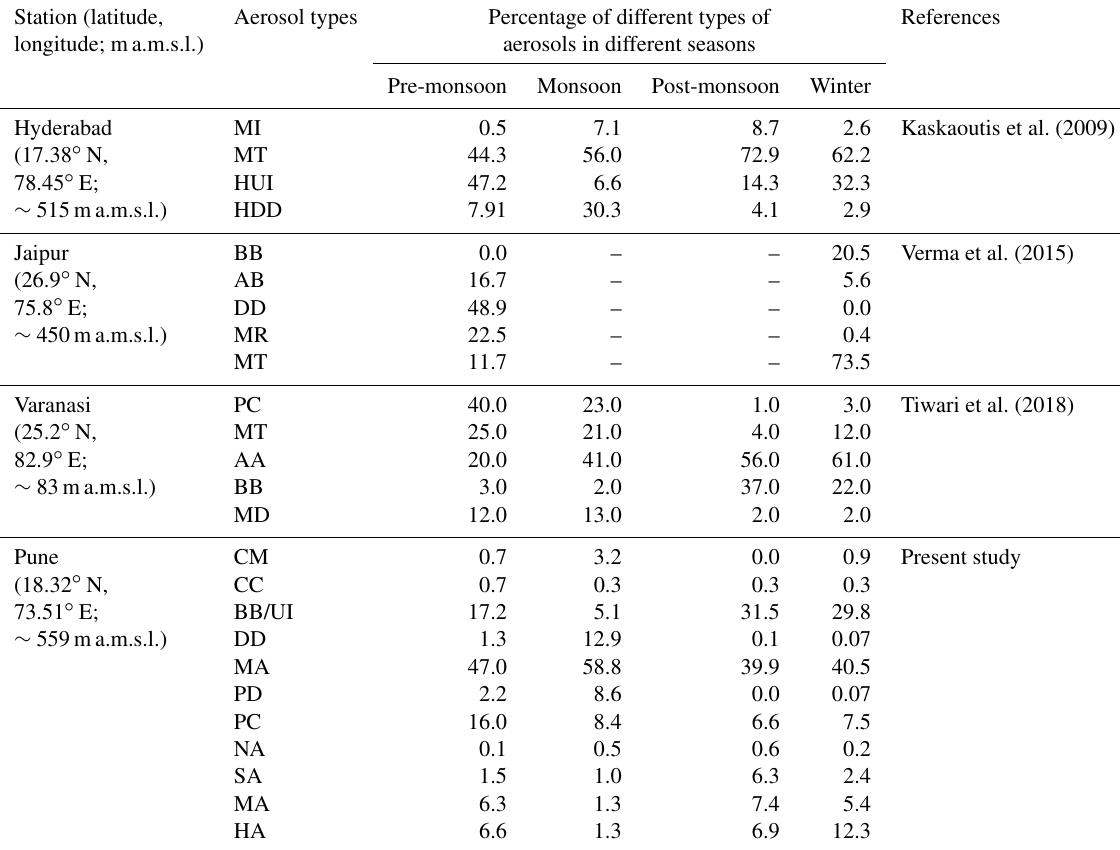
Table 1. Comparison of aerosol types at different stations in India. Station (latitude, Aerosol types Percentage of different types of longitude;